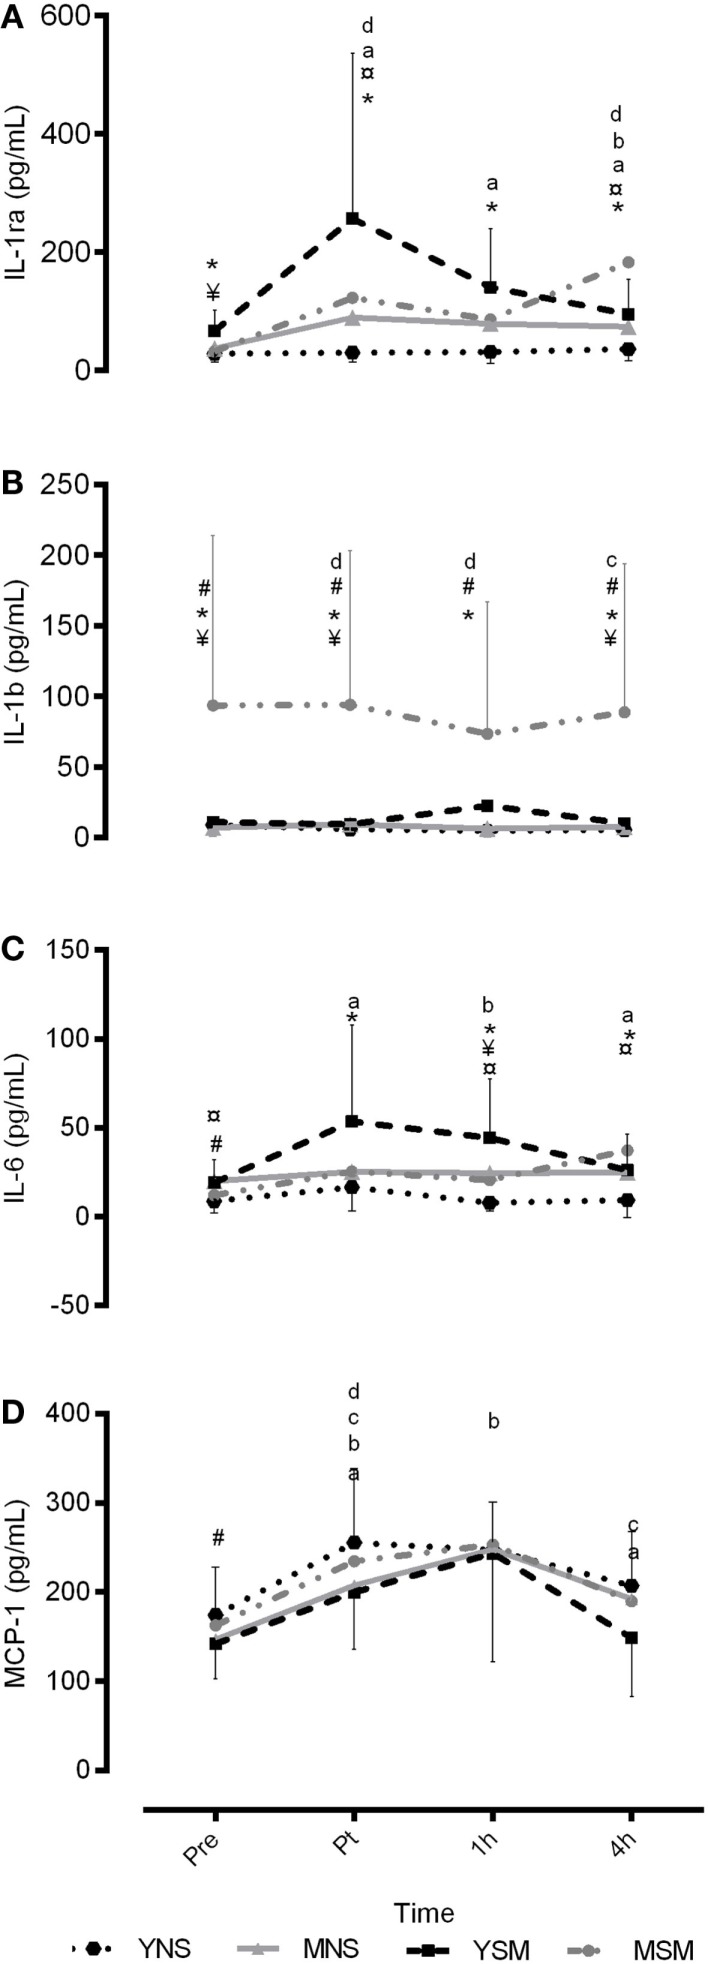
Mean ± SD inflammatory responses for IL-6, IL-1ra, IL-1β, and MCP-1 pre, post, 1 and 4 h post exercise for younger and middle-aged smokers and non-smokers. *represents significantly different between YSM and YNS (P < 0.05), # represents significantly between MSM and MNS (P < 0.05), ¥ represents significantly different between YSM and MSM (P < 0.05). ¤ represents significantly different between YNS and MNS (P < 0.05). Within changes for YSM, YNS, MSM, and MNS are represented by (A–D), respectively (P < 0.05).